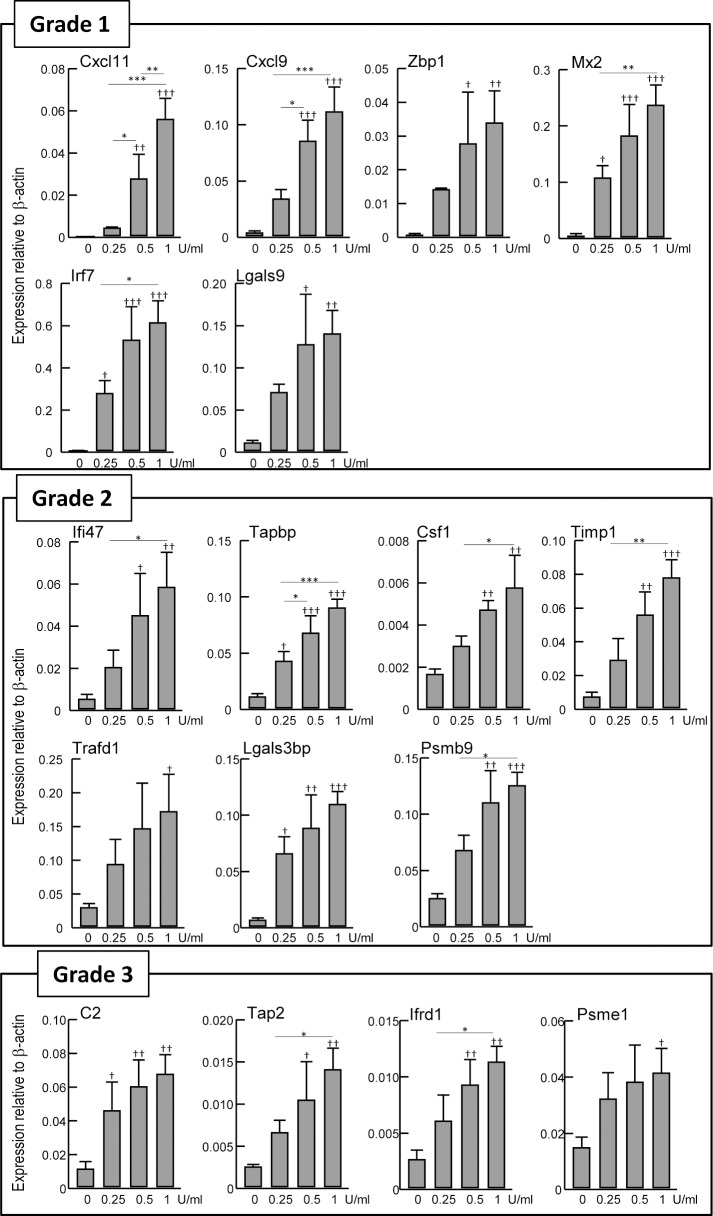
Gene expression analysis of RE treated rats.One lung lobe was obtained from rats treated with various concentrations of RE in Fig 1, and expression levels of genes were analyzed by bDNA-RNA, and were shown relative to β-actin. Three rats per group were used. Values are expressed as mean ± S.D. * P < 0.05, ** P < 0.01, *** P < 0.001. † P < 0.05 versus SA, †† P < 0.01 versus SA, ††† P < 0.001 versus SA.